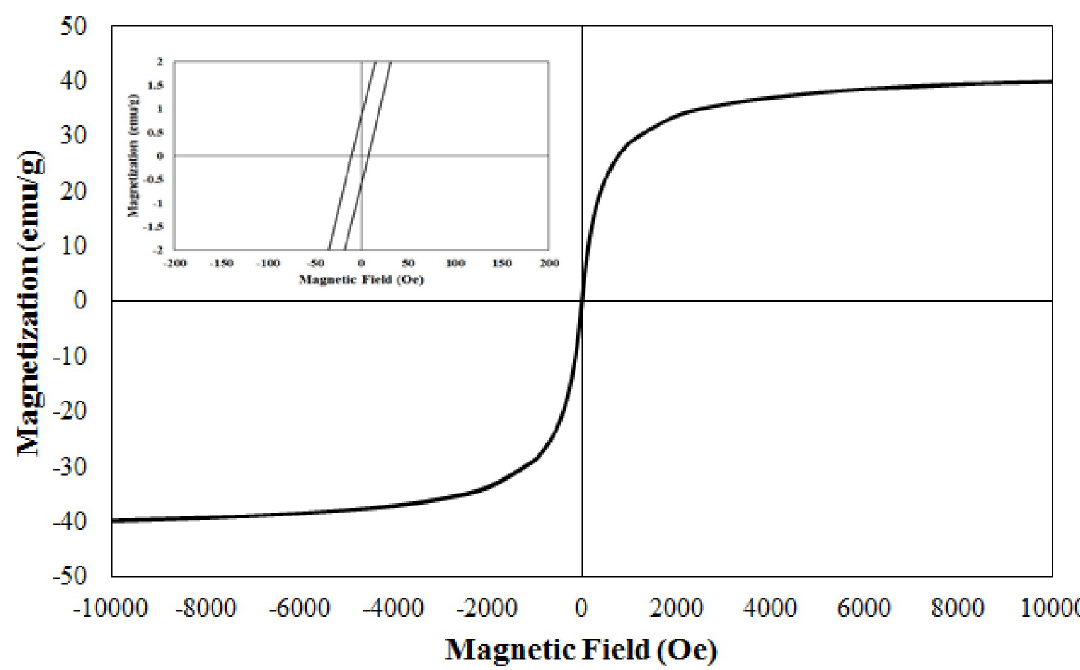
Fig 6. Room temperature magnetization curve and a close view of the magnetization curve (inset) of M-rGO3.